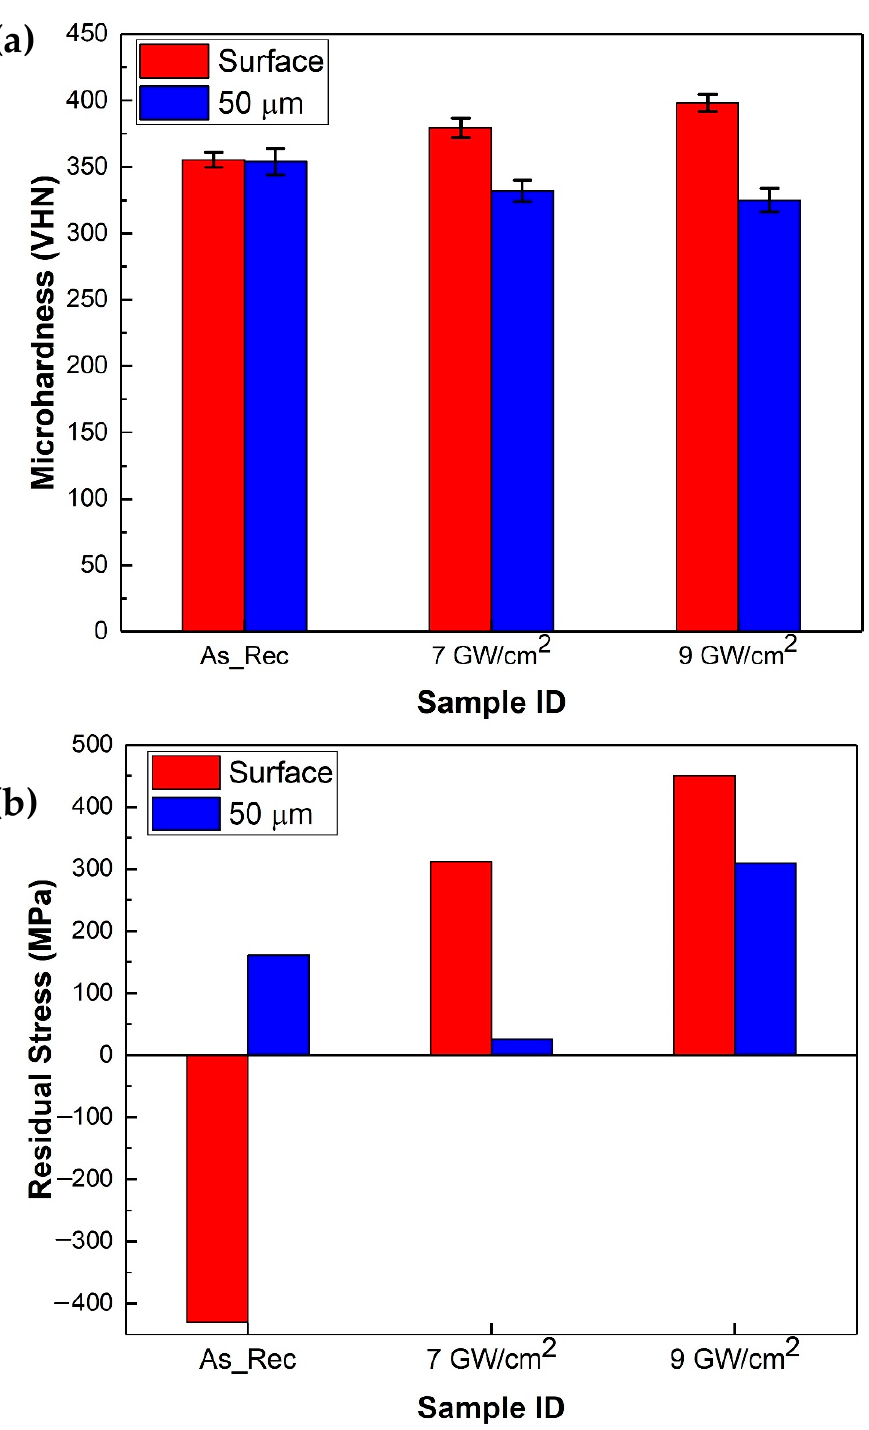
Figure 5. ( a ) Microhardness of the as-received, 7 GW/cm 2 peened and 9 GW/cm 2 peened Nitinol samples at the surface and at a depth of 50 μ m ( b ) Magnitude of the residual stress of the as-received, 7 GW/cm 2 peened and 9 GW/cm 2 peened Nitinol samples at the surface and a depth of 50 μ m. At a depth of 50 µ m, the microhardness of the as-received material was more or less similar to that of its surface counterpart, but the microhardness of the 7 and 9 GW/cm 2 samples was lower when compared to that of their corresponding surface